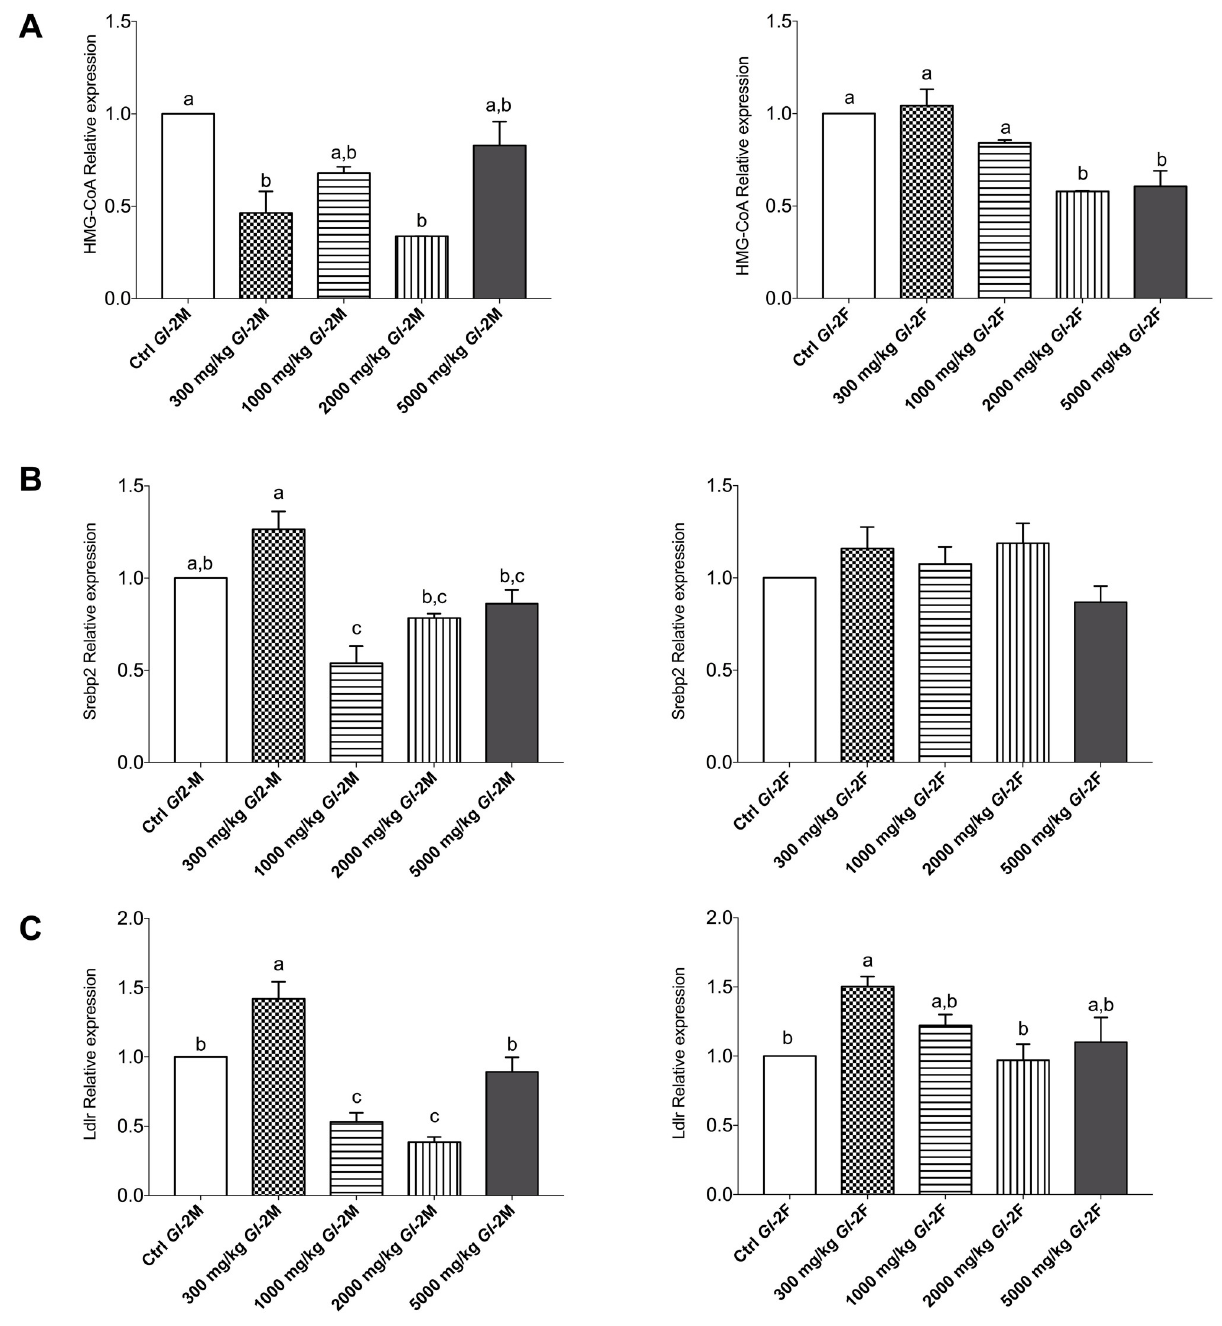
Fig 10. Expression of genes linked to cholesterol metabolism in liver tissue from male (M) or female (F) Wistar rats fed with the control diet (Ctrl) and different doses of the standardized Gl -2 extract of Ganoderma lucidum for 14 experimental days. A: HMG-CoA. B: Srebp2. C: Ldlr. Data are presented as mean ± SEM per experimental group. Different letters on a column indicate significant differences, p < 0.05. Values ( p ) correspond to one-way ANOVA from Tukey’s multiple comparison test. The dose administered per experimental group is described in the materials and methods